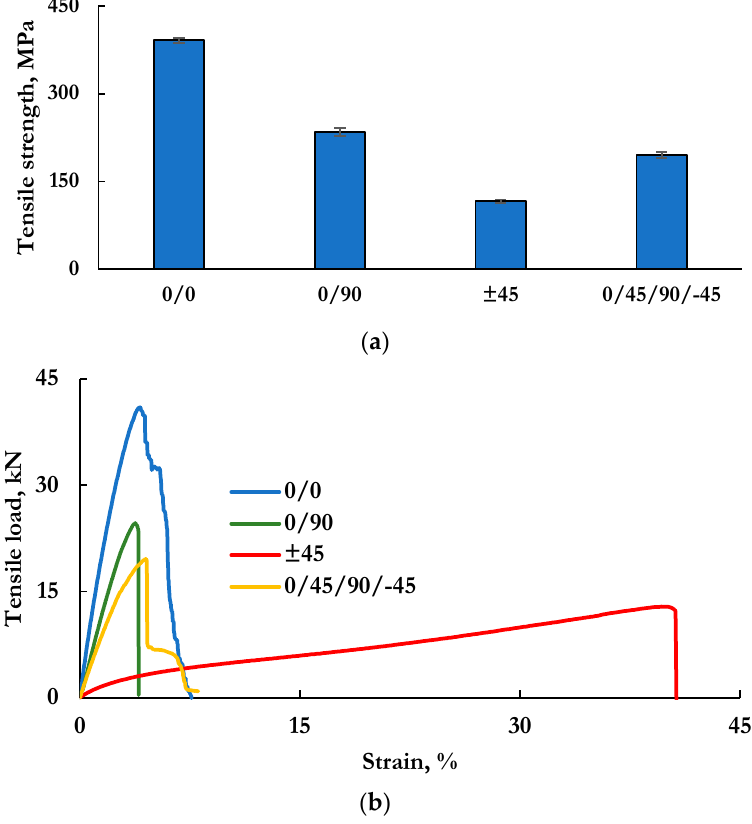
Figure 3. Tensile properties of the printed composites: ( a ) Tensile strength and ( b ) load–strain curves.